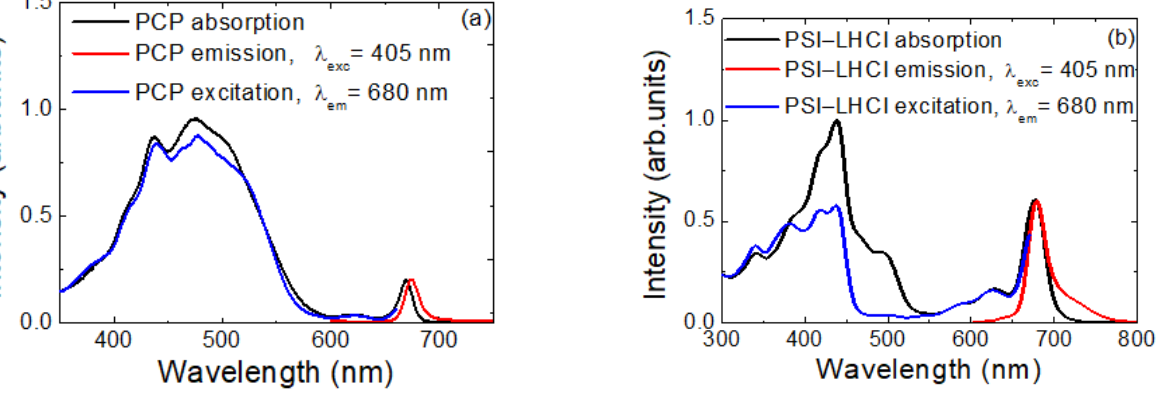
Figure 1. Spectral characteristics of PCP ( a ) and PSI–LHCI ( b ) aqueous-solution absorption spectra (black lines), emission spectra (red lines), and excitation spectra (blue lines).